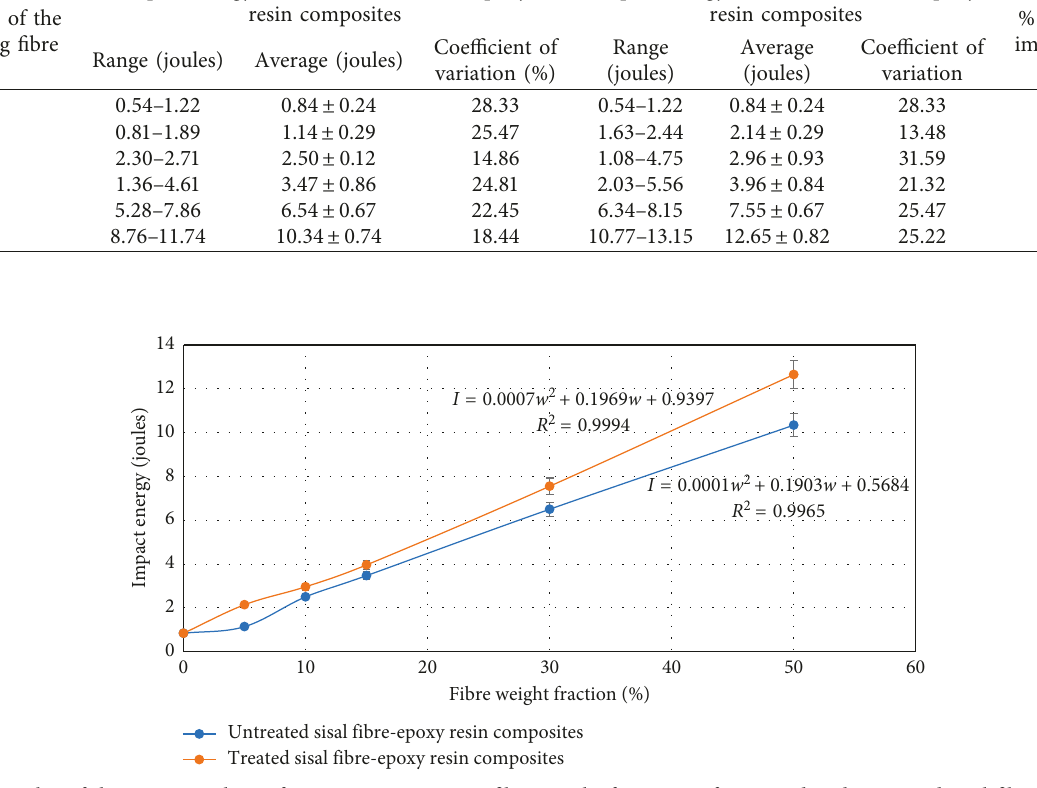
Table 1: Values of impact toughness for pure epoxy as well as treated and untreated sisal fibre-epoxy resin composites. Weight % of the reinforcing fibre